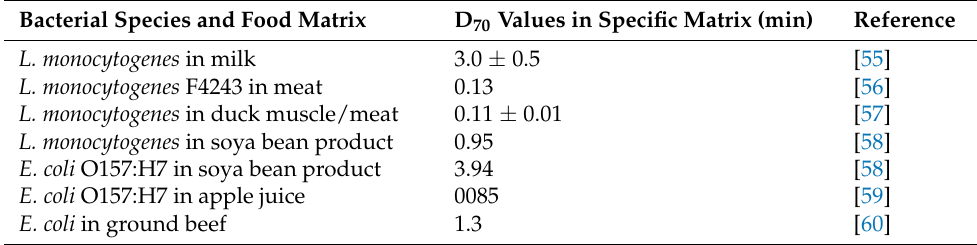
Table 3. D values of non-spore-forming